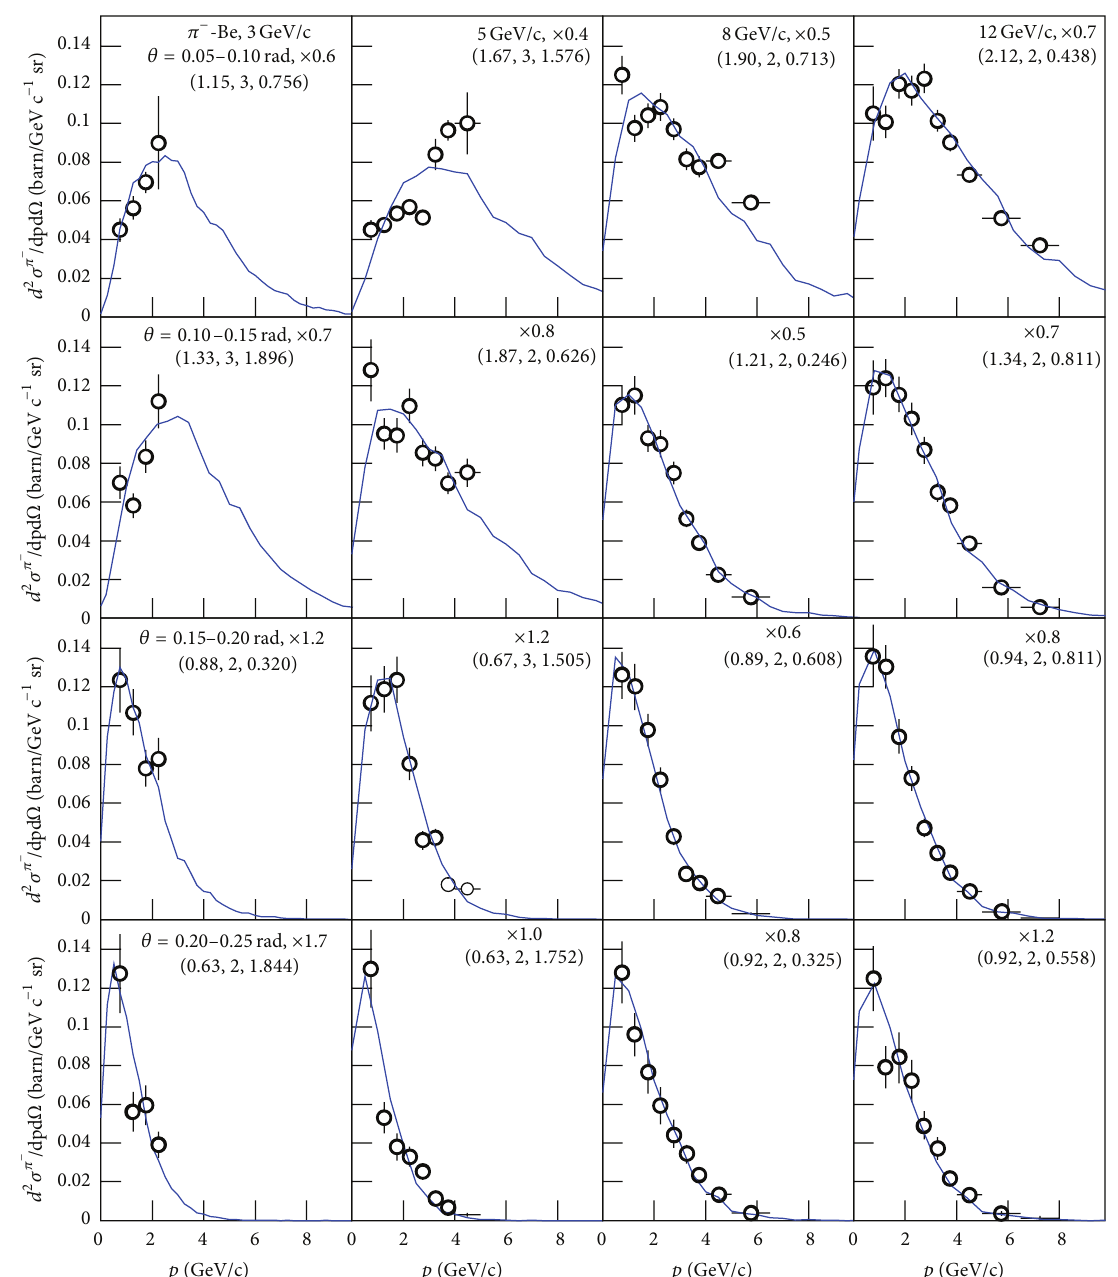
Figure 2: The same as Figure 1, but showing the results for 𝜋 − production cross